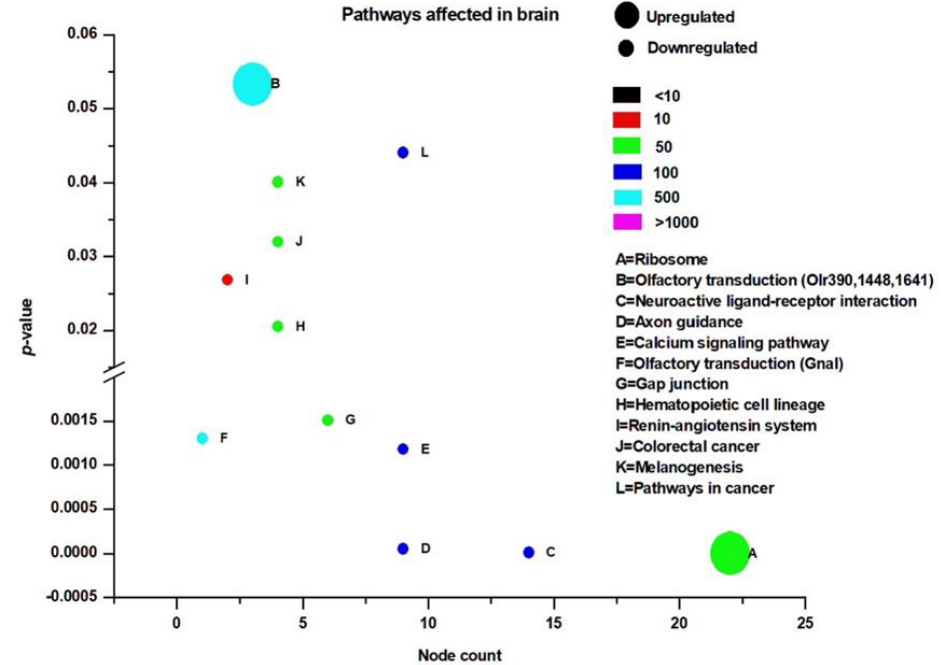
Figure 6. Kyoto Encyclopedia of Genes and Genomes (KEGG) pathways a ff ected by rapid eye movement sleep deprivation in rats in the brain. The x -axis depicts the number of nodes a ff ected and the y -axis shows the p -value ( p < 0.05). Color coding indicates the total number of database nodes evaluated. The size of the circle indicates the direction of change.